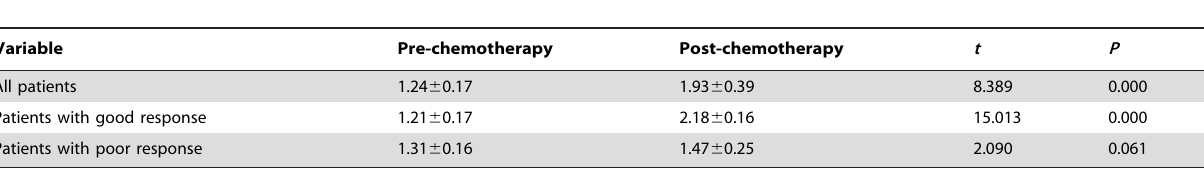
Table 2. Mean ADC values of whole tumor at pre- and post-chemotherapy ( 6 10 2 3 mm 2 /s).